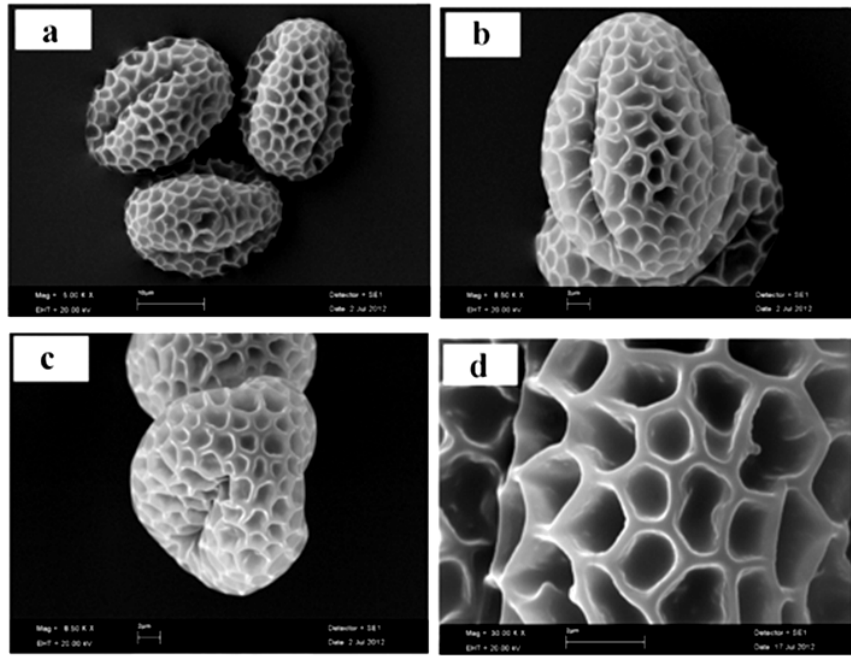
Fig. 7. SEM photographs of pollen of Matthiola anchoniifolia : a Multiple view of pollen (Scale: 10 µm) ; b Equatorial view and aperture (Scale: 2 µm); c Polar view and aperture (Scale: 2 µm) ; d Ornamentation (Scale: 2